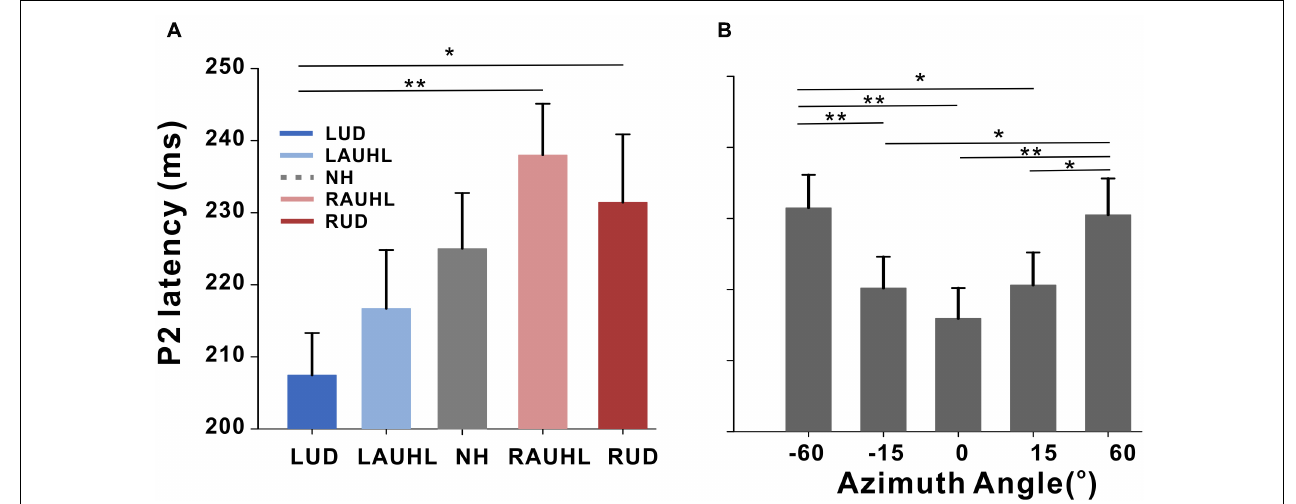
FIGURE 4 | P2 latencies for the subject groups (A) and azimuth angles (B) . Error bars: the standard error of the mean. * P < 0.05, ** P < 0.01. RUD, right-sided unilaterally deaf; LUD, left-sided unilaterally deaf; RAUHL, right-sided acute unilateral hearing loss; LAUHL, left-sided acute unilateral hearing loss; NH, normal hearing.